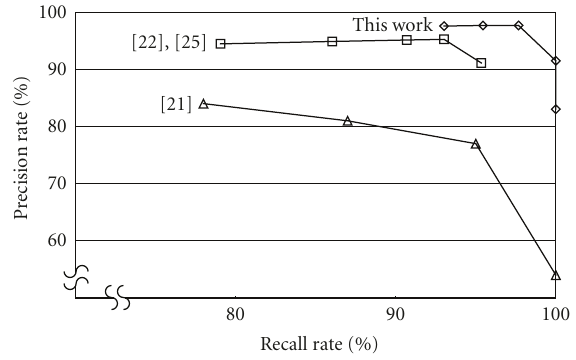
Figure 6: Performance comparison with previous approaches.